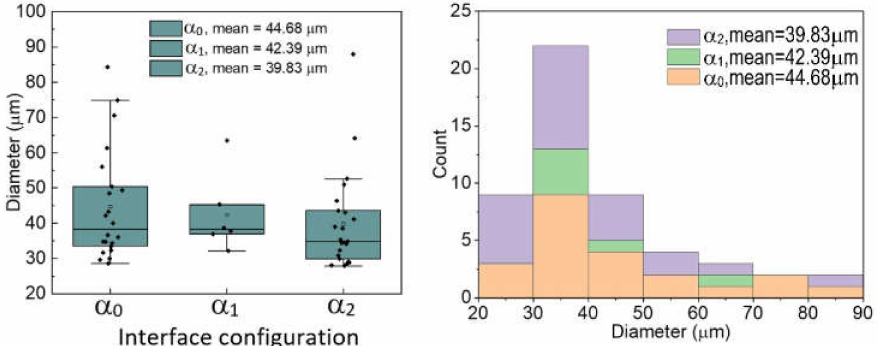
Figure 8. Porosity diameter and distribution of the welded joint with varied surface